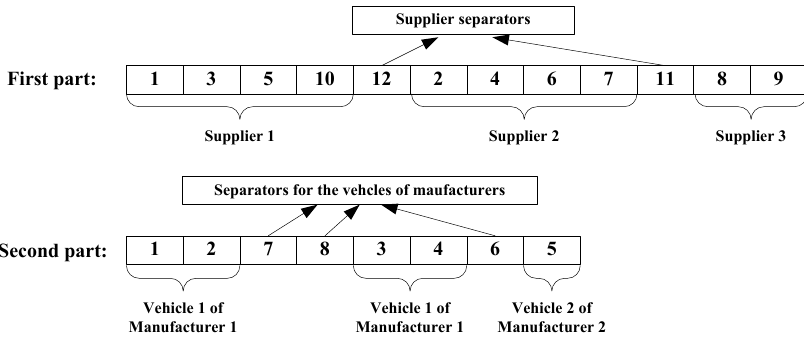
Figure 5. An instance for encoding the bat position.